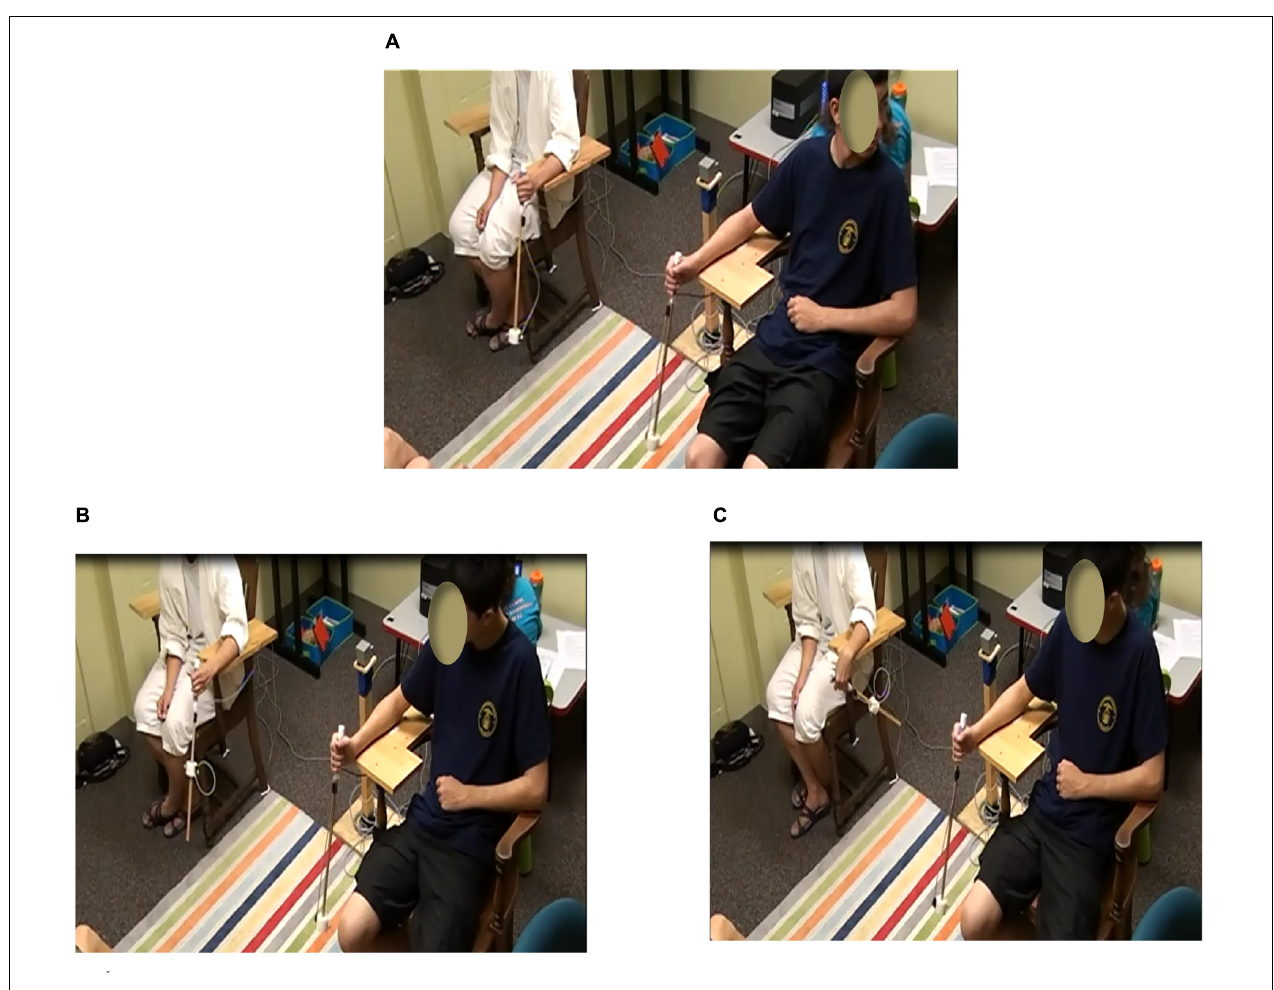
FIGURE 1 | Experimental set-up for the spontaneous and intentional pendulum task. Participants sat on chairs side-by-side while oscillating pendulums. In the spontaneous coordination conditions, participants coordinated their pendulums at their own tempo and looked away from each other’s pendulum during the “not looking” conditions (A) and toward the partner’s pendulum during the “looking” conditions. In the intentional coordination condition, participants looked at each other’s pendulum and swung the pendulums in either an in-phase coordination pattern (B) or an anti-phase coordination pattern (C)